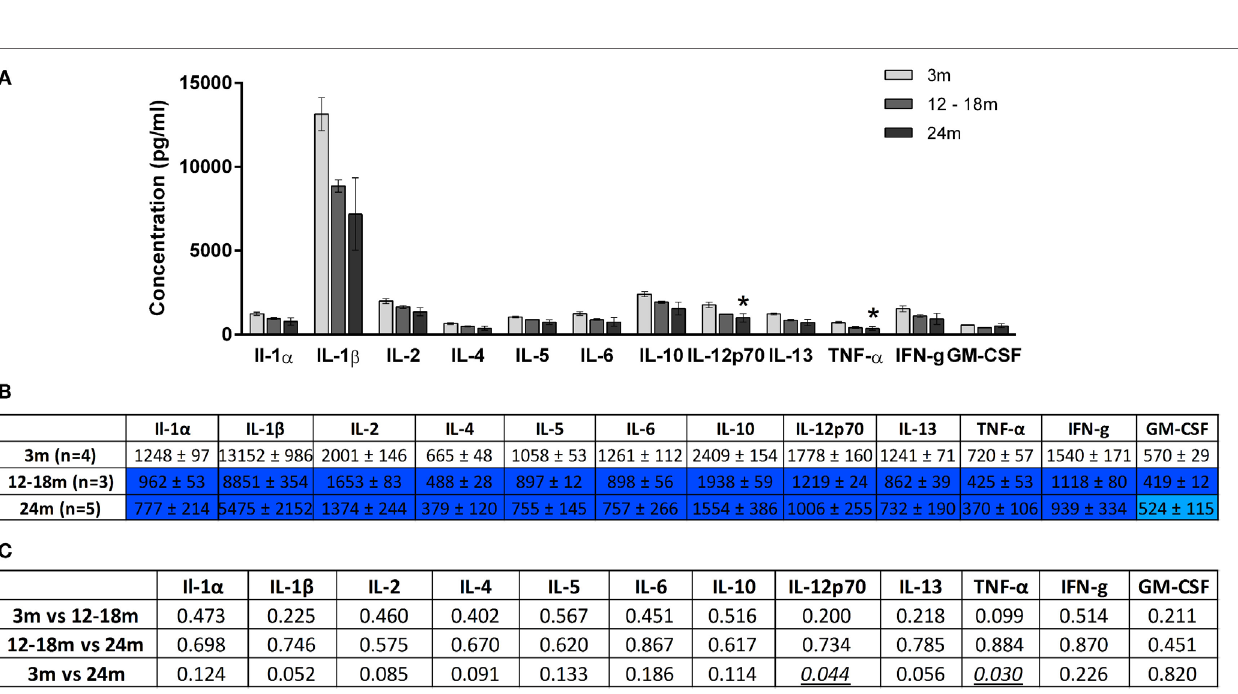
FigUre 5 | (a) Cytokine levels (picogram/milliliter, mean ± SEM) in the plasma of 3-, 12- to 18-, and 24-month-old rats. Asterisk denotes p < 0.05 vs. 3 months. (B) Color-coded table showing changes in cytokine levels in the plasma (mean ± SEM). Compared to 3-month-old rats (no color), > 15% decrease is represented by light blue and > 25% by dark blue. (c) Summary of p -values of plasma cytokine changes with age. Statistically significant differences are italicized and underlined. Note that changes in IL-1 β and IL-13 showed trends that were not statistically significant.